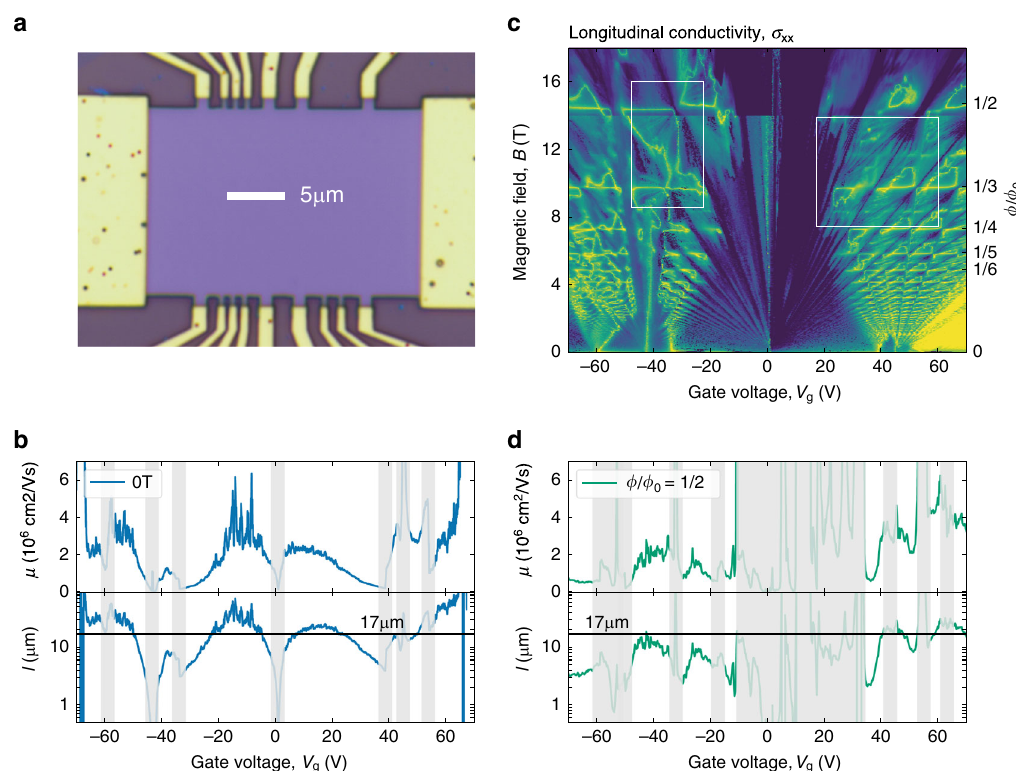
Fig. 1 High-quality graphene superlattices and their transport properties. a Optical micrograph of one of our devices (D1; twist angle θ between graphene and hBN of about 0.4°). The Hall bar is seen in violet with golden electrical contacts. b Mobility and mean free path for D1 measured at zero B and 10 mK. Semitransparent vertical strips indicate the doping regions around NPs and vHS where n could not be extracted directly from Hall measurements and charge inhomogeneity also plays a role. To calculate μ and l within the shaded regions, we assumed a constant gate capacitance and linearly extrapolated the n ( V g ) dependences found suf fi ciently far from NPs and vHS (Supplementary Note 3). The noisy behavior at large values of μ and l arises from ρ xx becoming small ( ∼ 1 Ohm, about 4 orders of magnitude smaller than that at the NPs). The horizontal black line indicates the device width W . c σ xx ( V g , B ) measured by sweeping V g and varying B in small steps of 40 mT. T = 10 and 250 mK below and above 14 T, respectively. Indigo-to-yellow colors: Log scale truncated between 38 nS and 16 mS for B < 14 T and between 4 nS and 0.4 mS above 14 T. White rectangles: these regions are shown in fi ner detail in Figs. 3 and 4. d Same as in ( b ) but for ϕ / ϕ 0 = 1/2 ( B ≈ 15 T); T = 250 mK. In addition to NPs and vHS, the gray strips also cover a wide region of the quantum Hall regime (| V g | < 20 V), which is dominated by large cyclotron gaps in the main graphene spectrum. The transport data used to calculate μ and l in ( b ) and ( d ) are shown in Supplementary Note